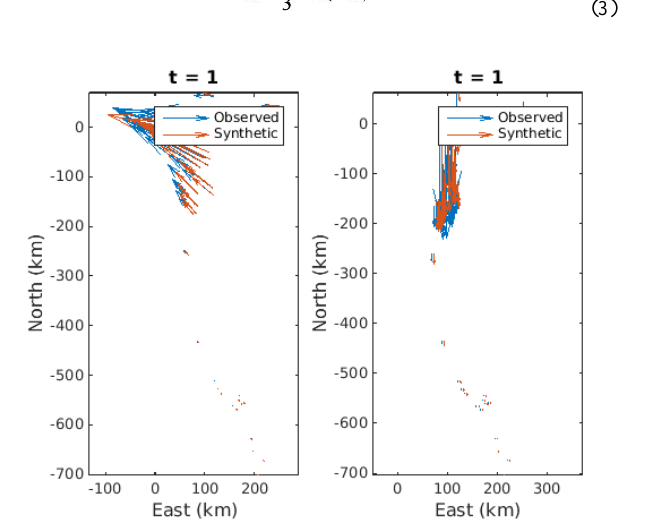
Figure 1: Results of observation vs sythetic displacements for a test case